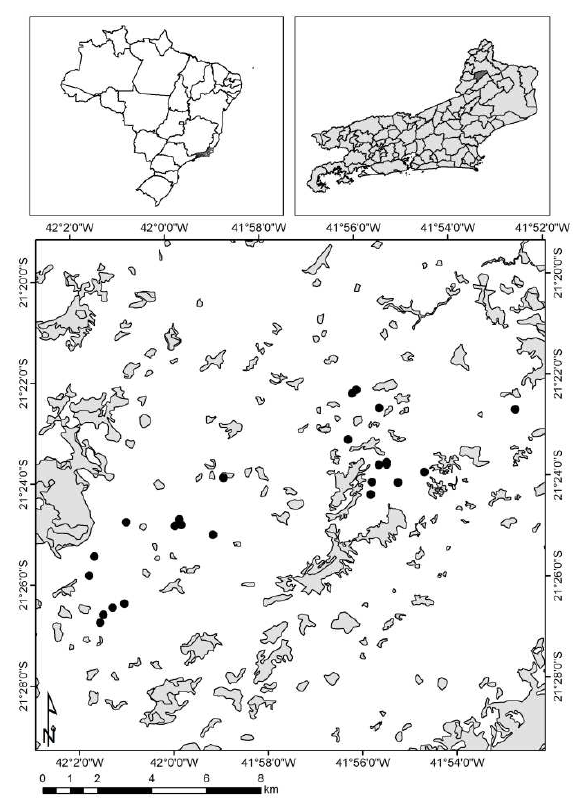
F IGURE 1. Location of the 24 studied crop areas (black circles) in northwest Rio de Janeiro state (map above right) in Brazil (left). Grey areas indicate forest fragments in the